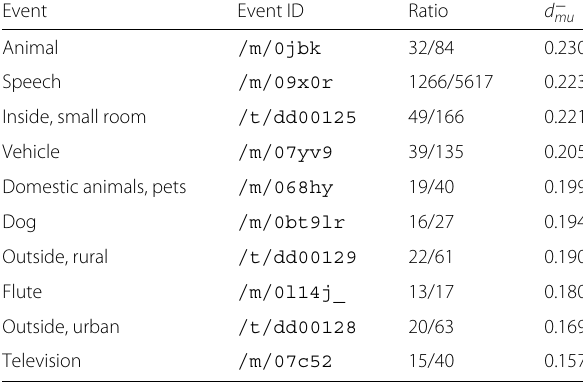
Table 12 Top-10 negative distractor events for music (event labels related to false negative decisions of the network about the “Music” class)